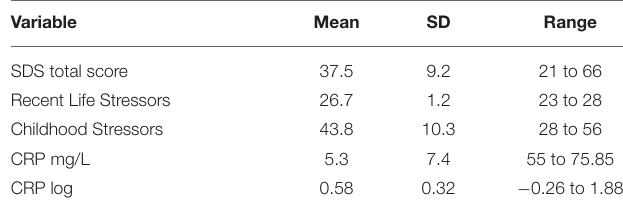
TABLE 1 | Distributions of all dependent variables.